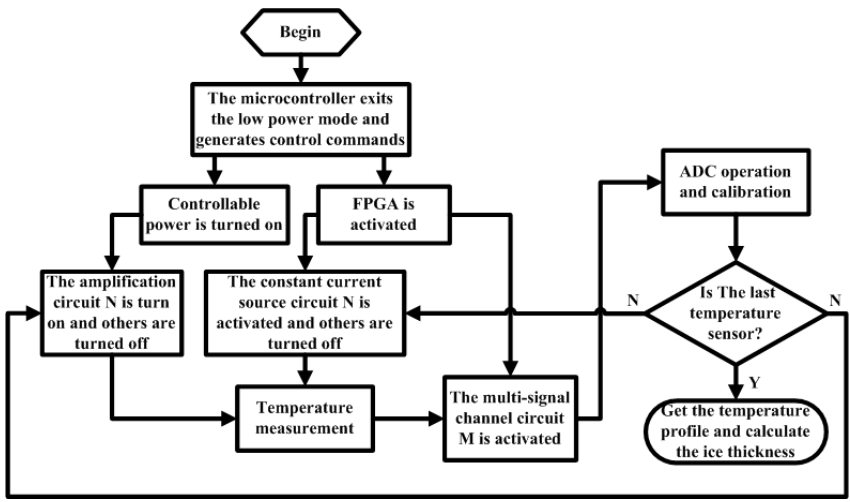
Figure 3. The flow chart of temperature measurement.